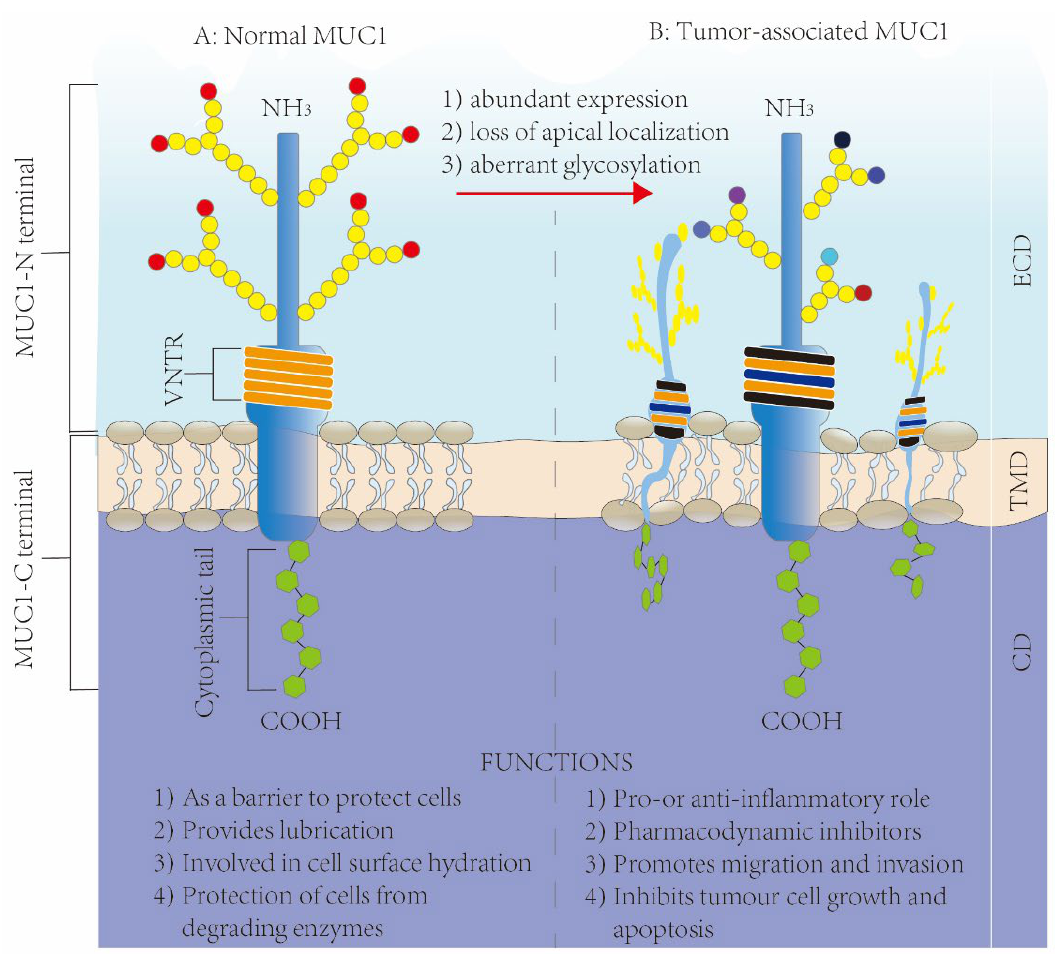
Figure 3. Structure and functions of MUC1 in normal tissues and diseased tissues: ( A ) the structure of MUC1 in normal tissues; ( B ) the structure of MUC1 in tumor tissues.